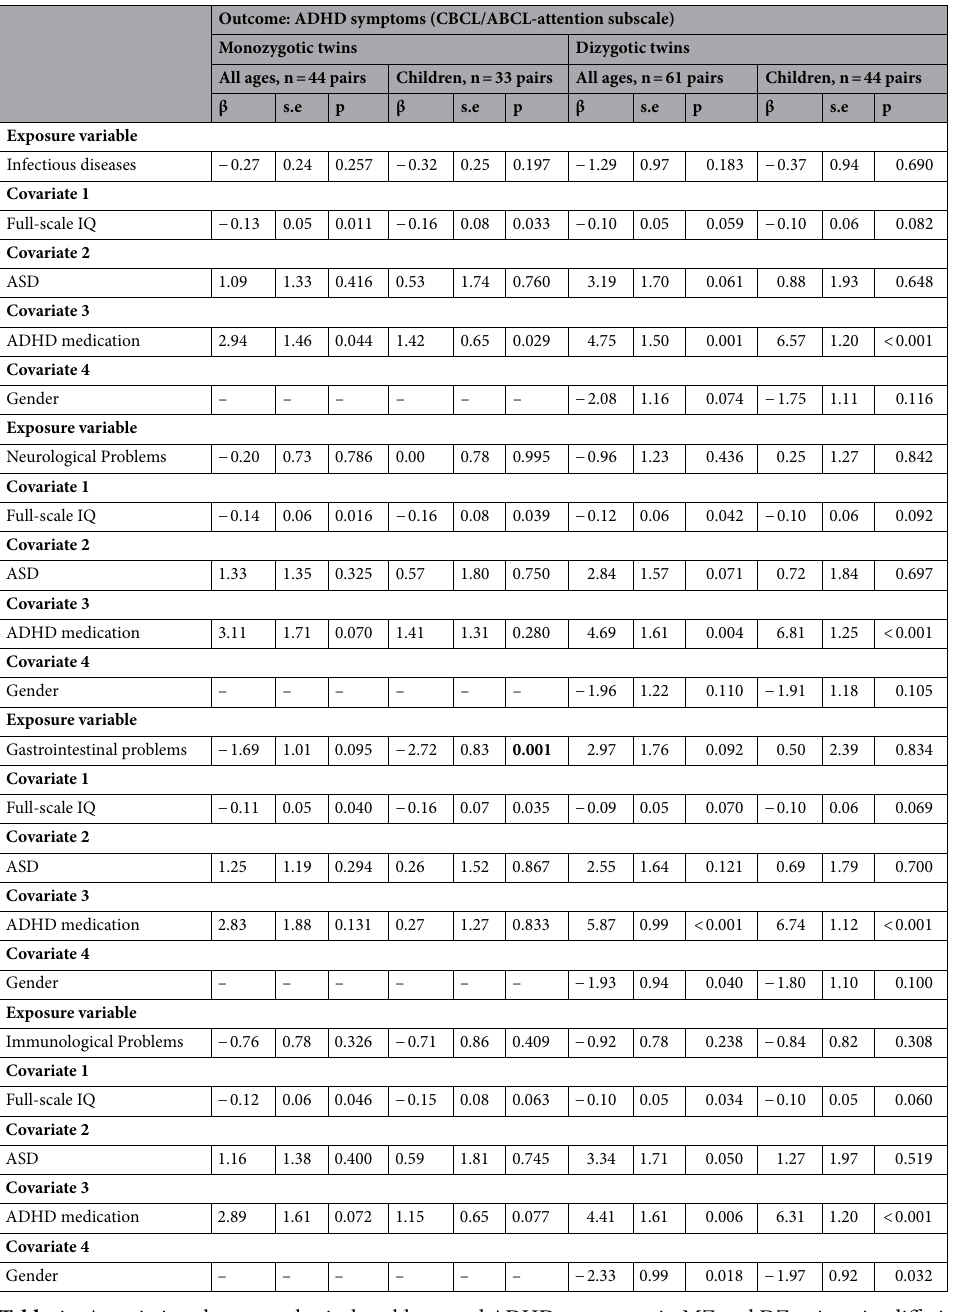
Table 4. Associations between physical problems and ADHD symptoms in MZ and DZ twin pairs differing for ADHD symptoms (p value unadjusted). Bold value indicate statistical significance *p < 0.0125. With Bonferroni correction, the significance level of p values in this table is set at p < 0.0125. ADHD attention- deficit/hyperactivity disorder, ASD autism spectrum disorder, CBCL the Child Behavior Checklist, ABCL Adult Behaviour